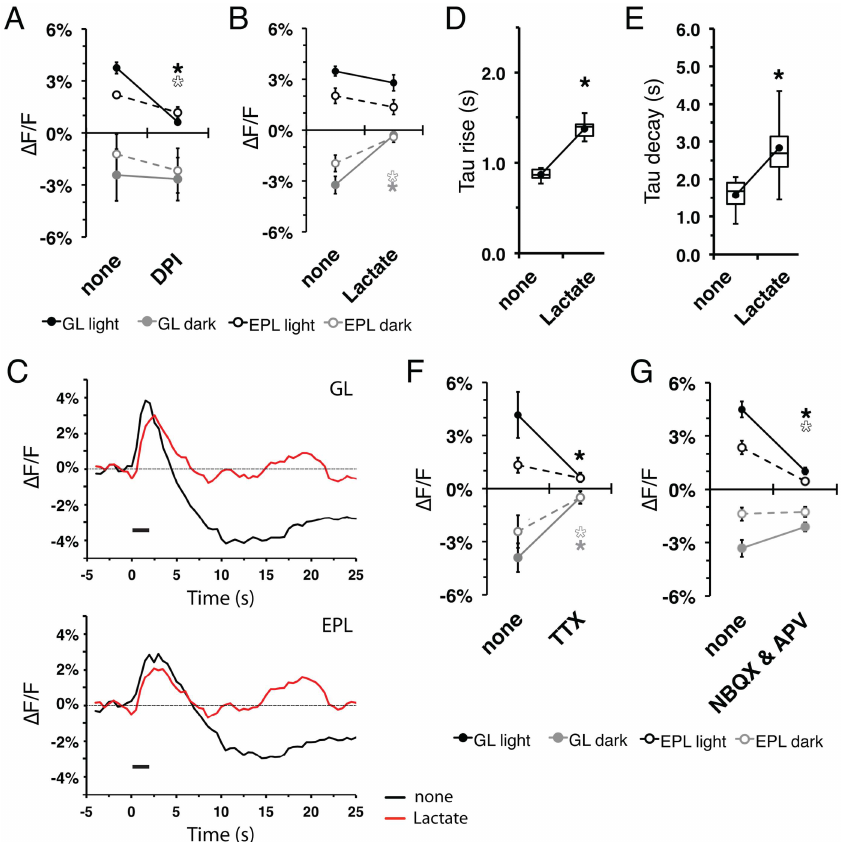
Fig 5. Metabolic and neuronal origins of the intrinsic flavoprotein signal response. (A) Mean flavoprotein signal amplitudeof the light phase(black) and dark phase(gray) from the GL (solid) and EPL (dash) upon treatment with 10 μ M DPI. (B) Mean flavoprotein signal amplitudeof the light and dark phases with 15 mM lactate ACSF substitution. (C) Representative mean ROI traces from the activated glomerulus (top) and EPL (bottom). Line: stimulus train deliveryand duration. (D and E) GL mean light phase time-to- peak (D) and time-to-trough (E) before and duringlactate substitution. (F) Treatment with 10 μ M TTX resulted in decreased light and dark phaseamplitudes in the GL and EPL. (G) Mean signal peak amplitudesof light phaseand dark phasein the GL and EPL upontreatment with ionotropicglutamate receptorblockers 10 μ M NBQX and 50 μ M